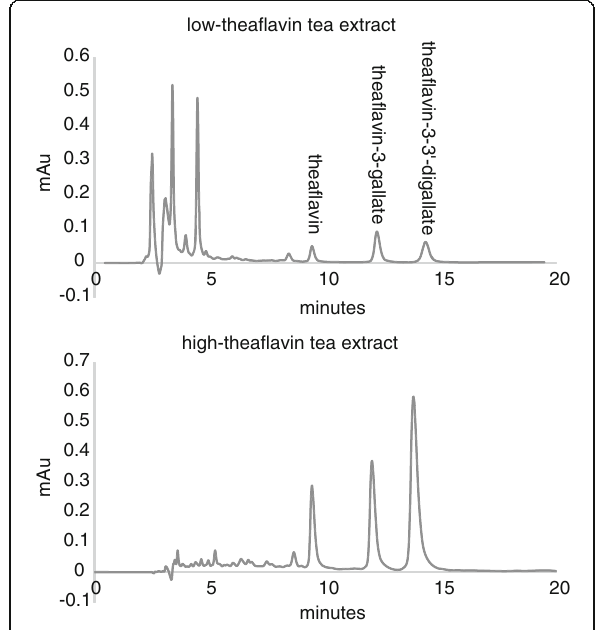
Fig. 2 HPLC of theaflavin-containing black tea extracts. The equivalent of 20 μ g of powder extract was injected onto the HPLC column for each chromatogram